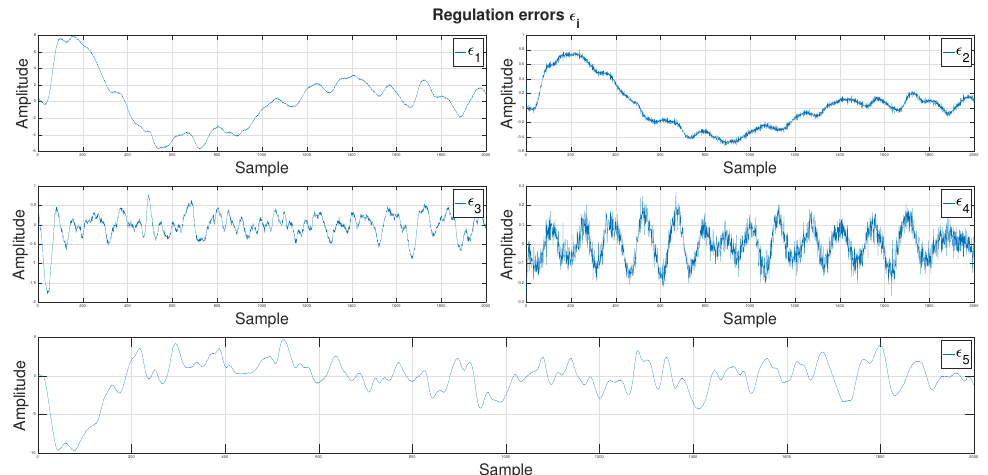
Figure 5. Control errors time series for the simulation data impacted by the Gaussian noise and Cauchy disturbance.